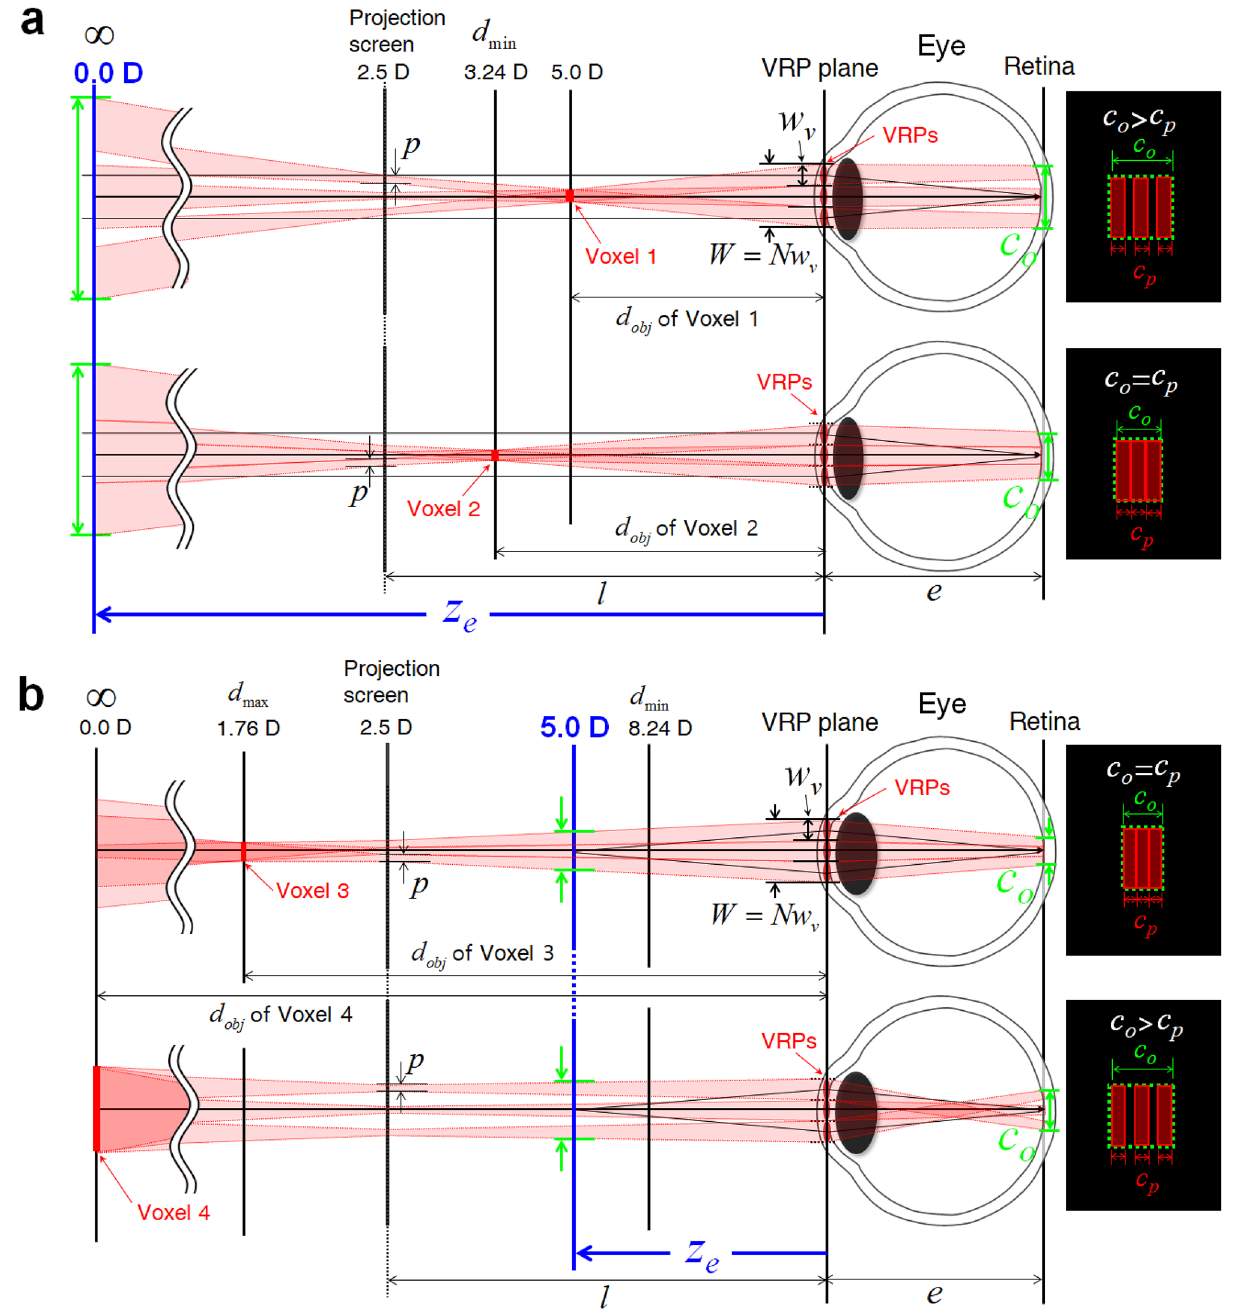
Figure 6. Defocused voxel images of four voxels on the retina plane. Voxels 1, 2, 3 and 4 are positioned at 5.0, 3.24, 1.76 and 0.0 diopters, respectively. ( a ) Images of defocused voxel 1 and voxel 2 at z e = 0.0 diopters. ( b ) Images of defocused voxel 3 and voxel 4 at z e = 5.0